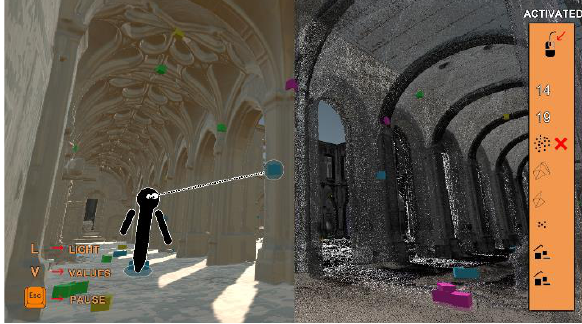
Figure 14. Users can choose the most appropriate representation of a historic site (in this case, a high-poly mesh (left) and dense point cloud (right) to identify further cultural values associated with the place and its constitutive